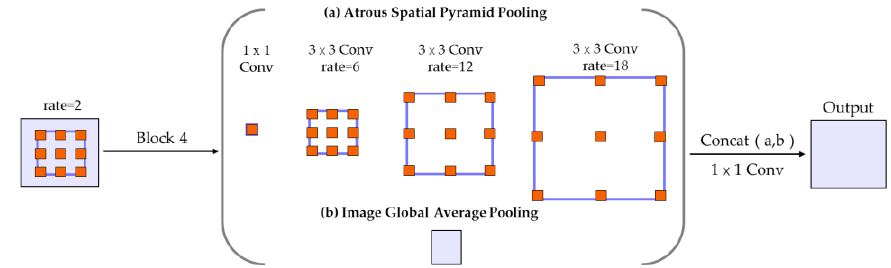
Figure 5. The structure of atrous spatial pyramid pooling module used in Deeplab v3. The module consists of two steps including ( a ) atrous convolution and ( b ) image pooling, and produces the final output by a convolution layer after concatenation of feature maps (revised after [16]).